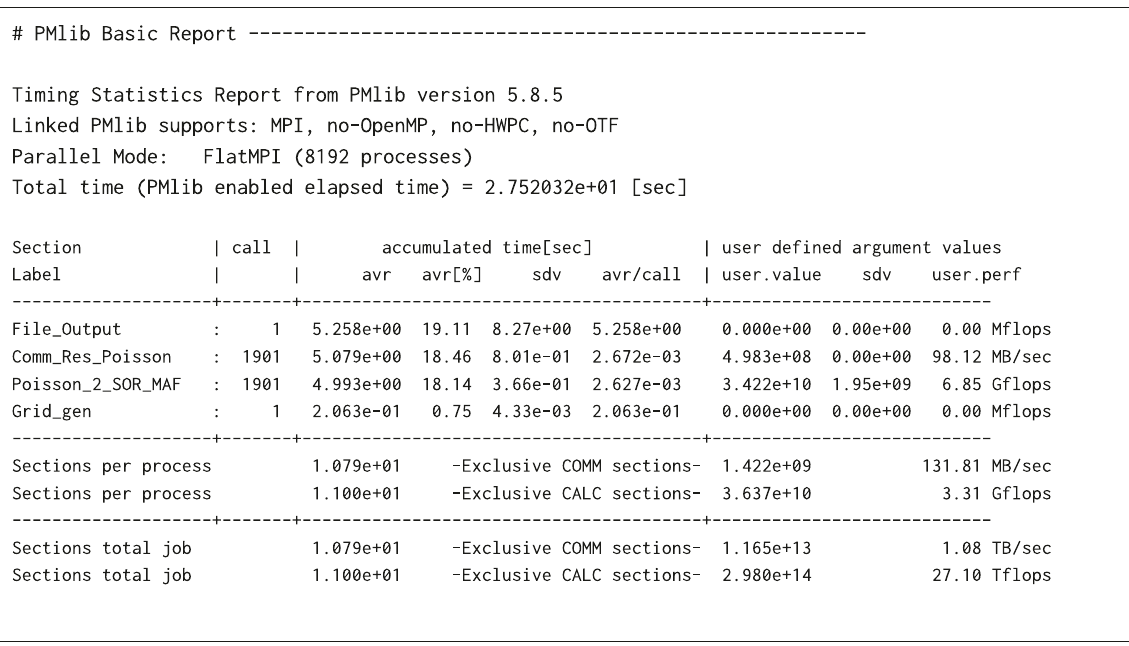
Figure 9: Example report generated by PMlib . Table 1: Specifications of ITO subsystem